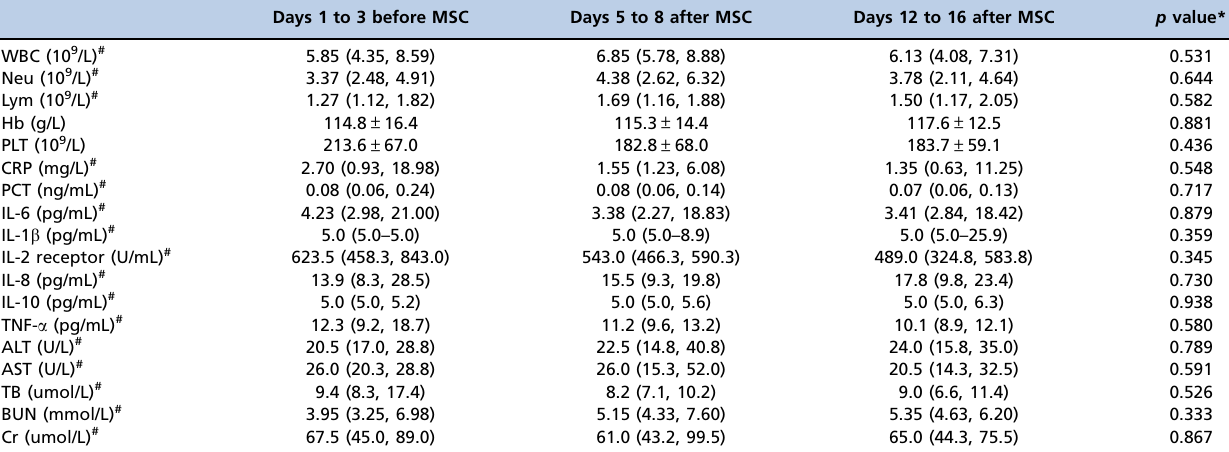
Table 3 - Comparisons of biomarker levels at three time points in patients treated with mesenchymal stem cell. Days 1 to 3 before MSC Days 5 to 8 after MSC Days 12 to 16 after MSC p value*